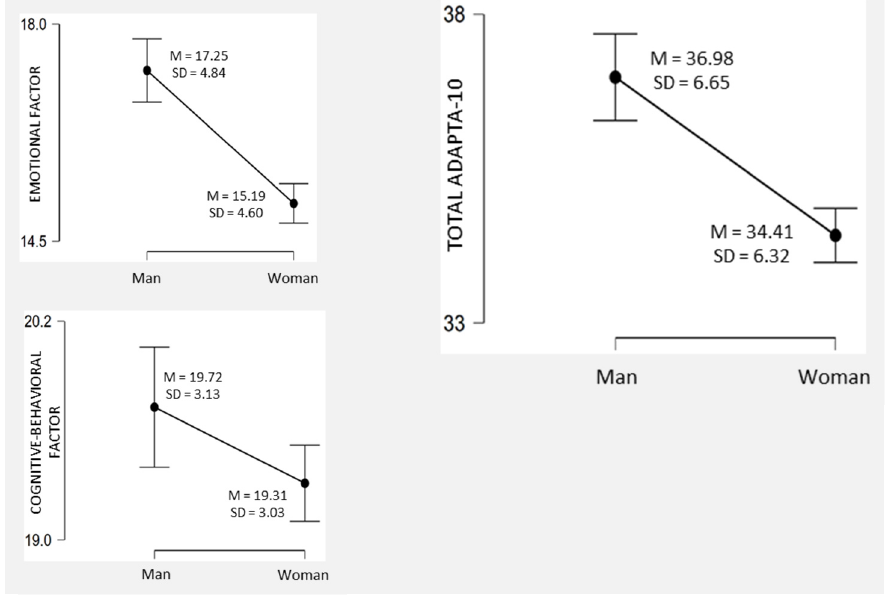
Figure 2. Adaptation to change by sex, descriptive